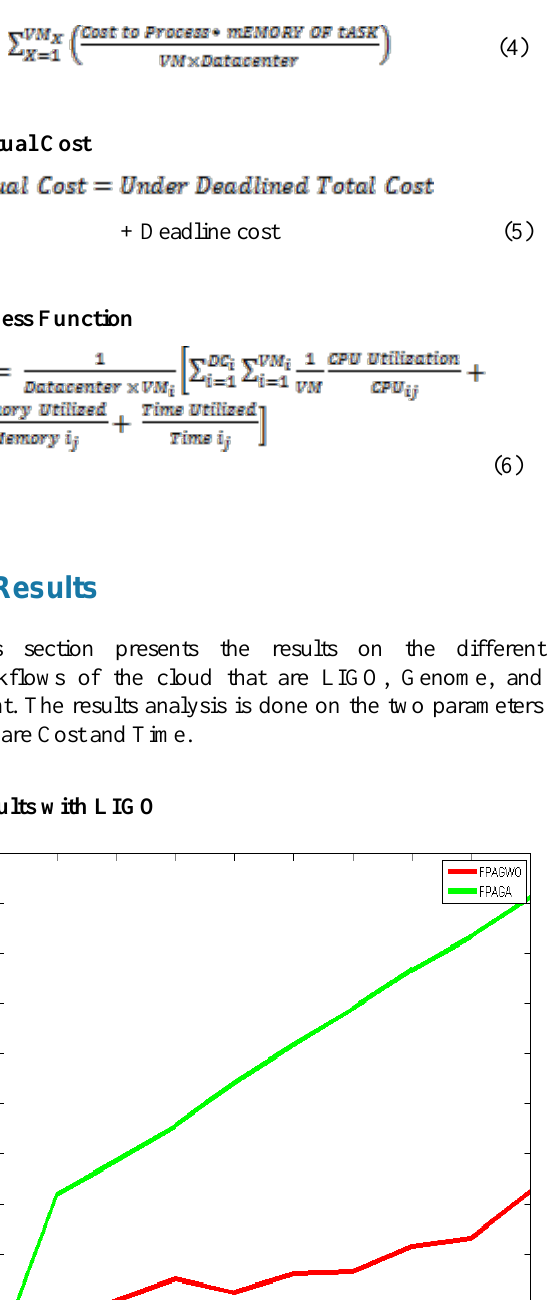
FPA_GA. In Figure 3 comparison of flower pollination algorithm with genetic algorithm (FPGA) and flower pollination algorithm with grey wolf optimization (FPAGWO) on Cost parameter. The cost analysis is